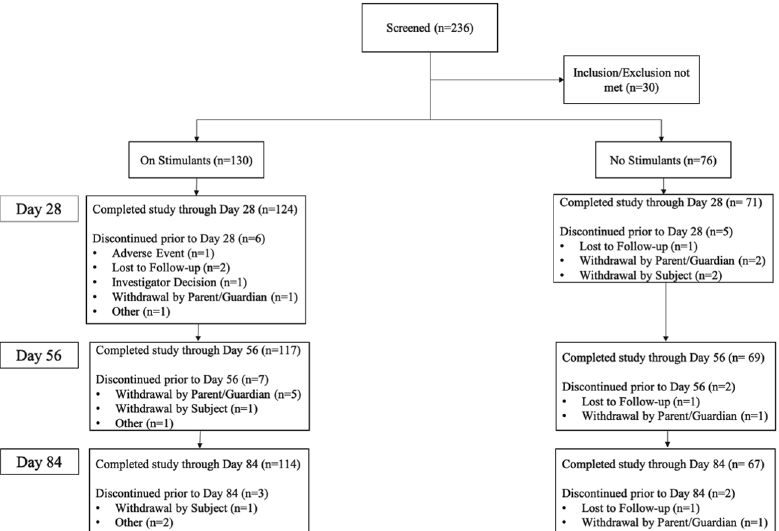
Fig. 1 Trial Consort Table. Of the three AE-related withdrawals, one was coded as AE, two were coded as subject withdrawal (one in stimulant, one in no stimulant